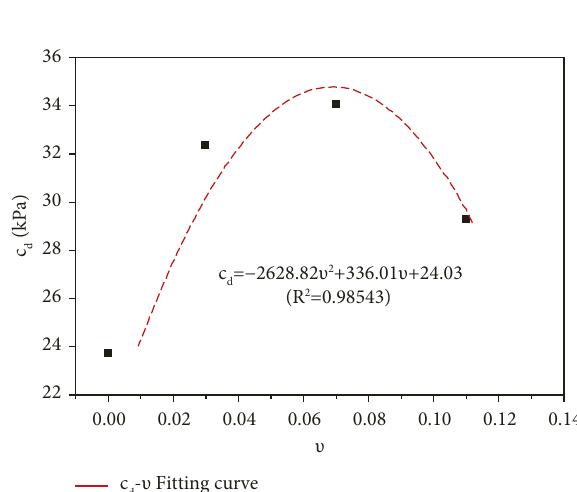
Figure 10: Dynamic stress-strain curve. (a) σ